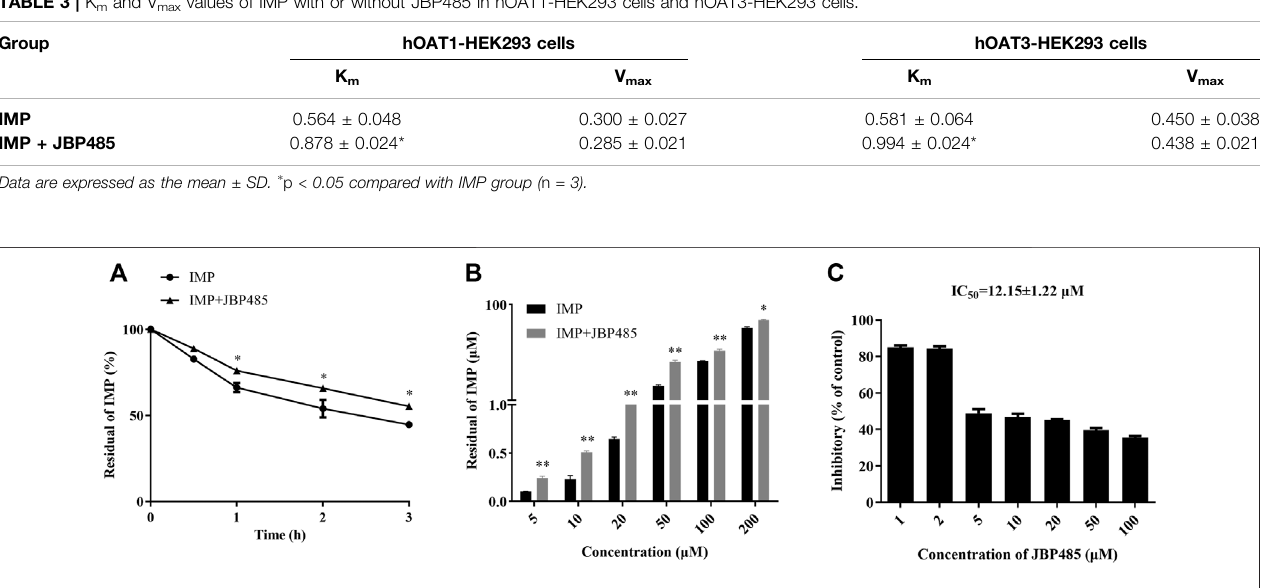
Frontiers in Pharmacology |